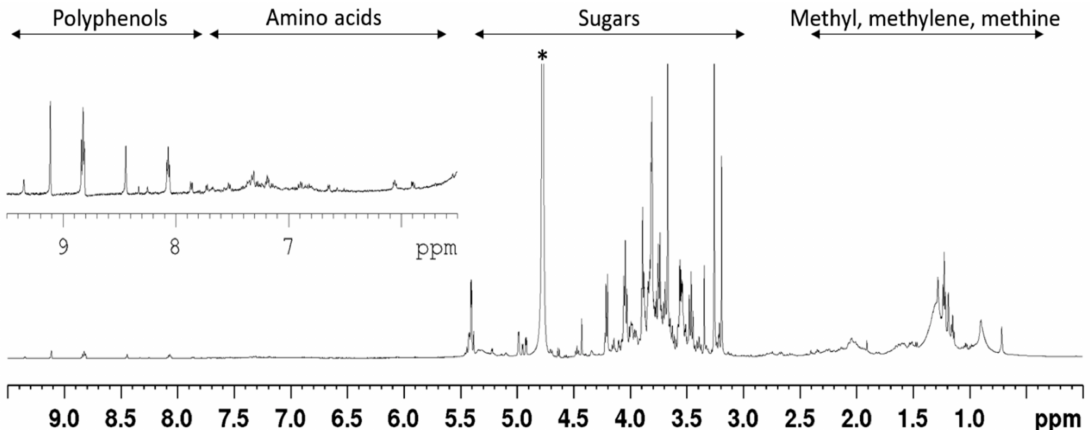
Figure 2. The 1 H-NMR (Nuclear Magnetic Resonance) spectrum indicates that the AC extract consists primarily of sugars, and of minor amount of polyphenols and amino acids. The extract was analysed by NMR spectrometry in D 2 O at 25 ◦ C. The 1 H-NMR spectrum, indicates the presence of at least four groups of components, with sugars constituting the major fractions of the extract; * denote the solvent (D 2 O)